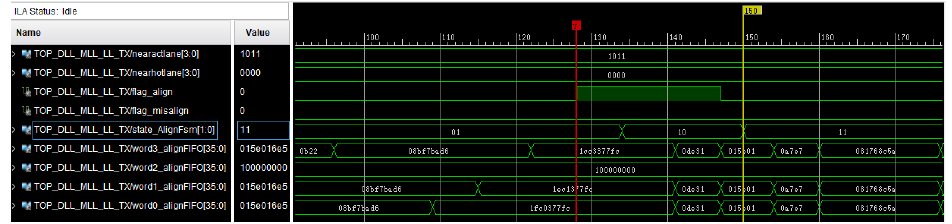
Figure 13. The ILA waveform in the alignment subsystem.